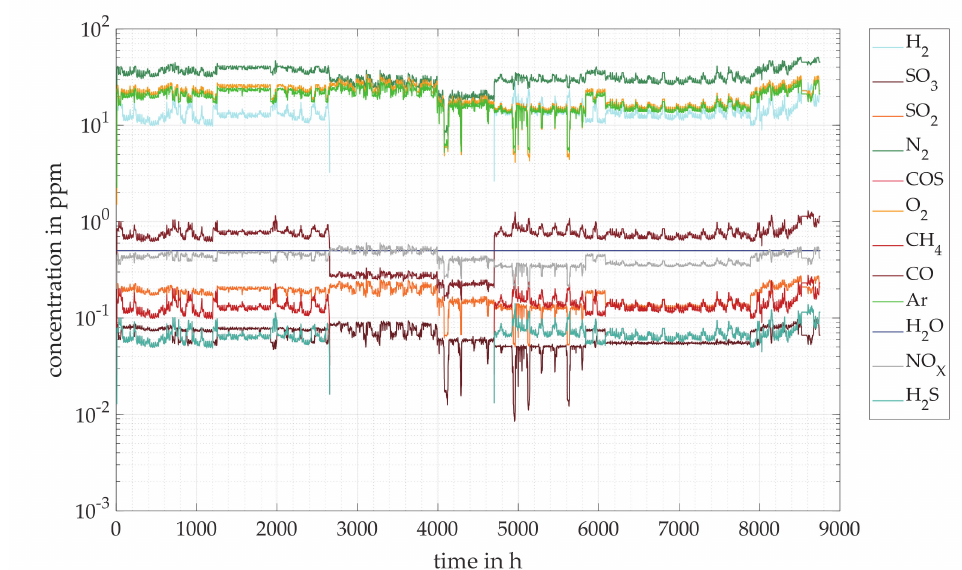
Figure 6. Simulated variation (hourly averages) of individual impurity concentrations within the CO 2 stream at the entry of the trunk pipeline throughout one year ( = 8760 h) for the baseline scenario “RE 27%” (T = 288 K, p inlet ≤ 12.33 MPa; note that COS concentration data are hidden behind the H 2 S data as its concentration values are identical to those of H 2 S throughout the year).